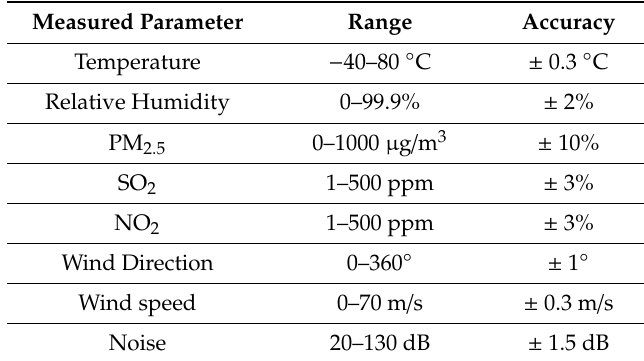
Table 5. The measured range and accuracy of CESMS sensors.